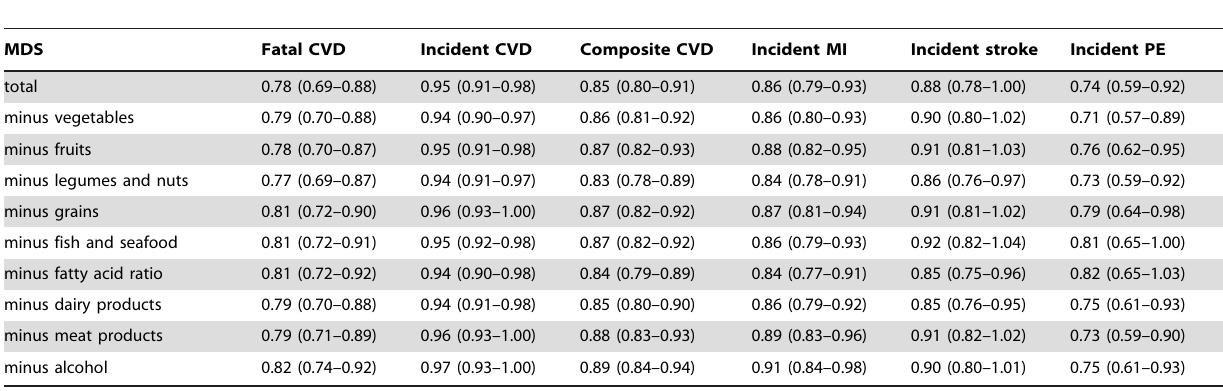
Table 3. Hazard ratios (95%CI) associated with two unit increment in MDS and after alternate exclusion of each of its components.